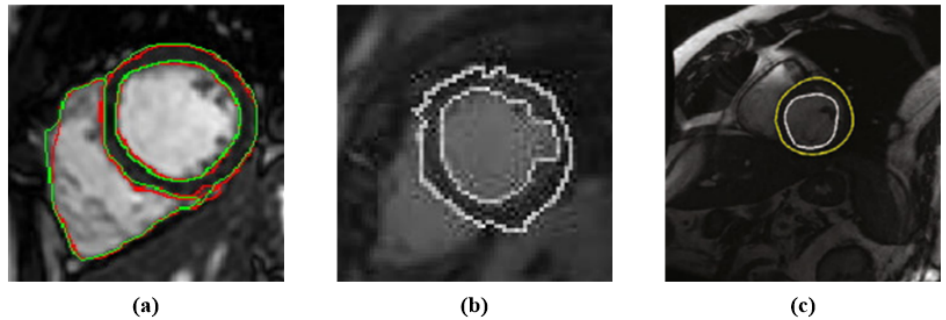
Figure 2. Traditional segmentation methods. ( a ) Thresholding. Automated contours (green) and manual contours (red). ( b ) Clustering. ( c ) Active